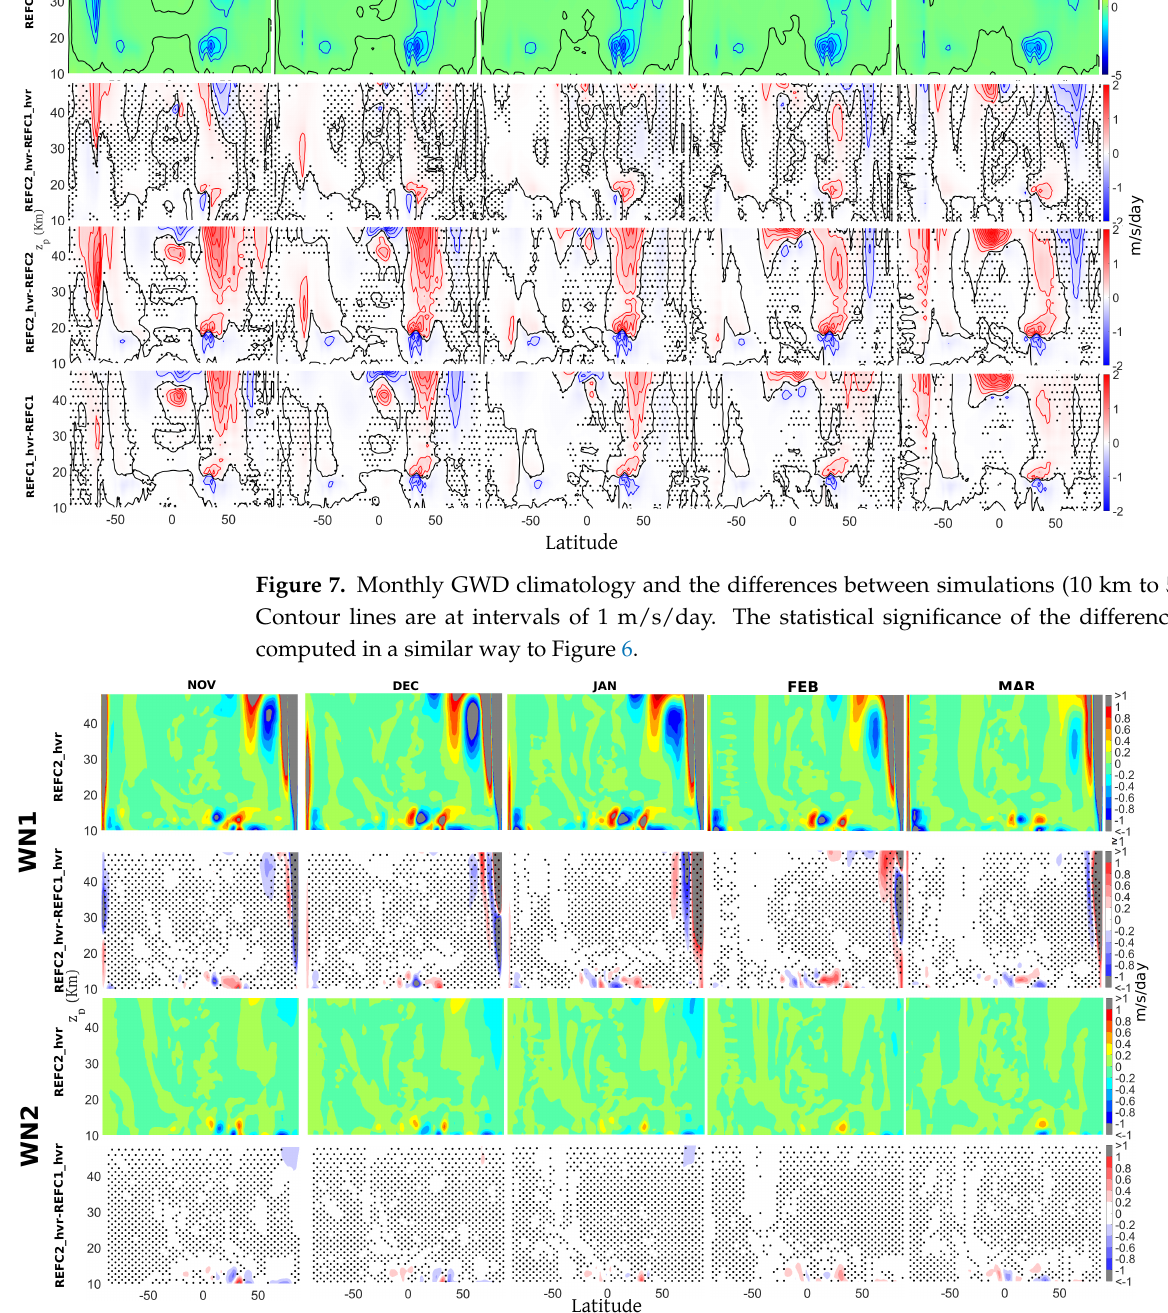
Figure 8. Monthly climatology in EPFD due to WN1 and WN2 for high-vertical resolution simulations and differences between them. For November to March (from left to right). The statistical significance of the differences was computed in a similar way to Figure